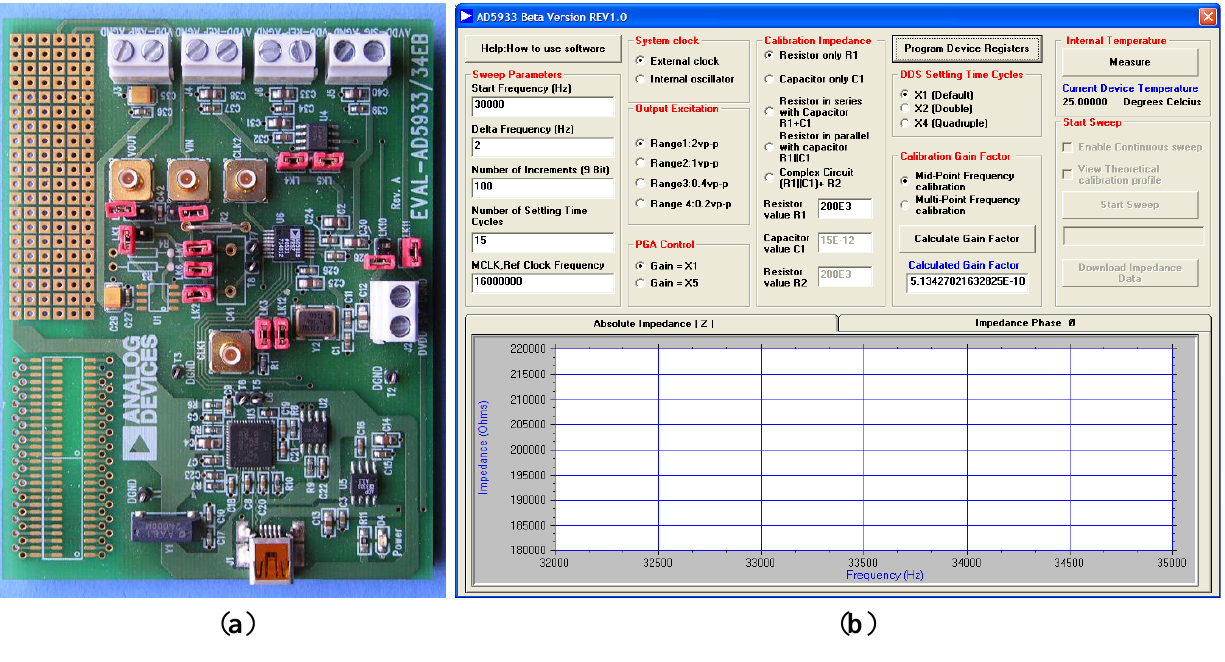
Figure 5. Hardware and software utilized for data acquisition: ( a ) AD5933 evaluation board and ( b ) snapshot of the supporting software graphic user